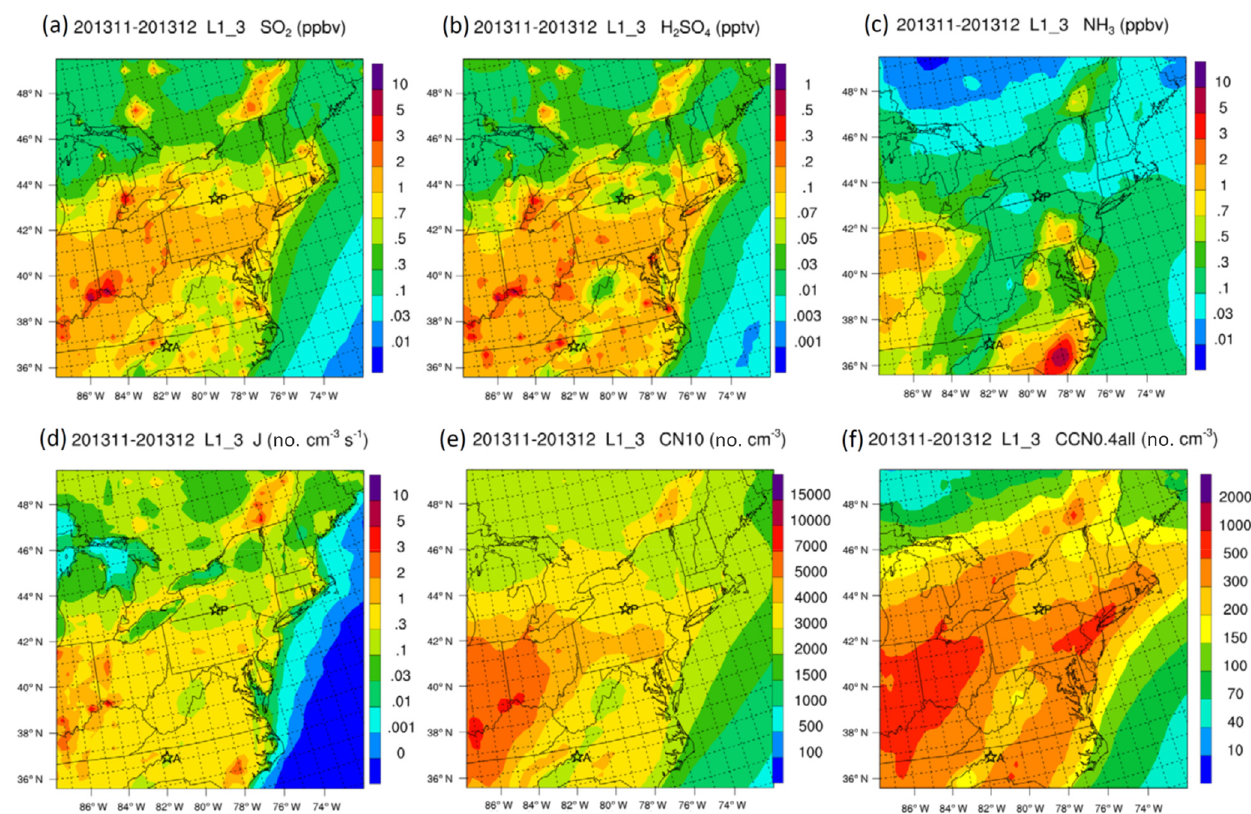
Figure 1. Horizontal spatial distribution of WRF-Chem–APM-simulated average wintertime (November–December 2013) (a) [SO 2 ], (b) [H 2 SO 4 ], (c) [NH 3 ], (d) nucleation rate ( J ), (e) number concentration of condensation nuclei > 10nm (CN10), and (f) cloud con- densation nuclei at supersaturation 0.4% (CCN0.4) in the lower boundary layer ( ∼ 0–400m above surface, first three model layers) over the Northeastern United States (NEUS). Measurement sites Appalachian State University (A), North Carolina, and Pinnacle State Park (P), New York, are marked on the